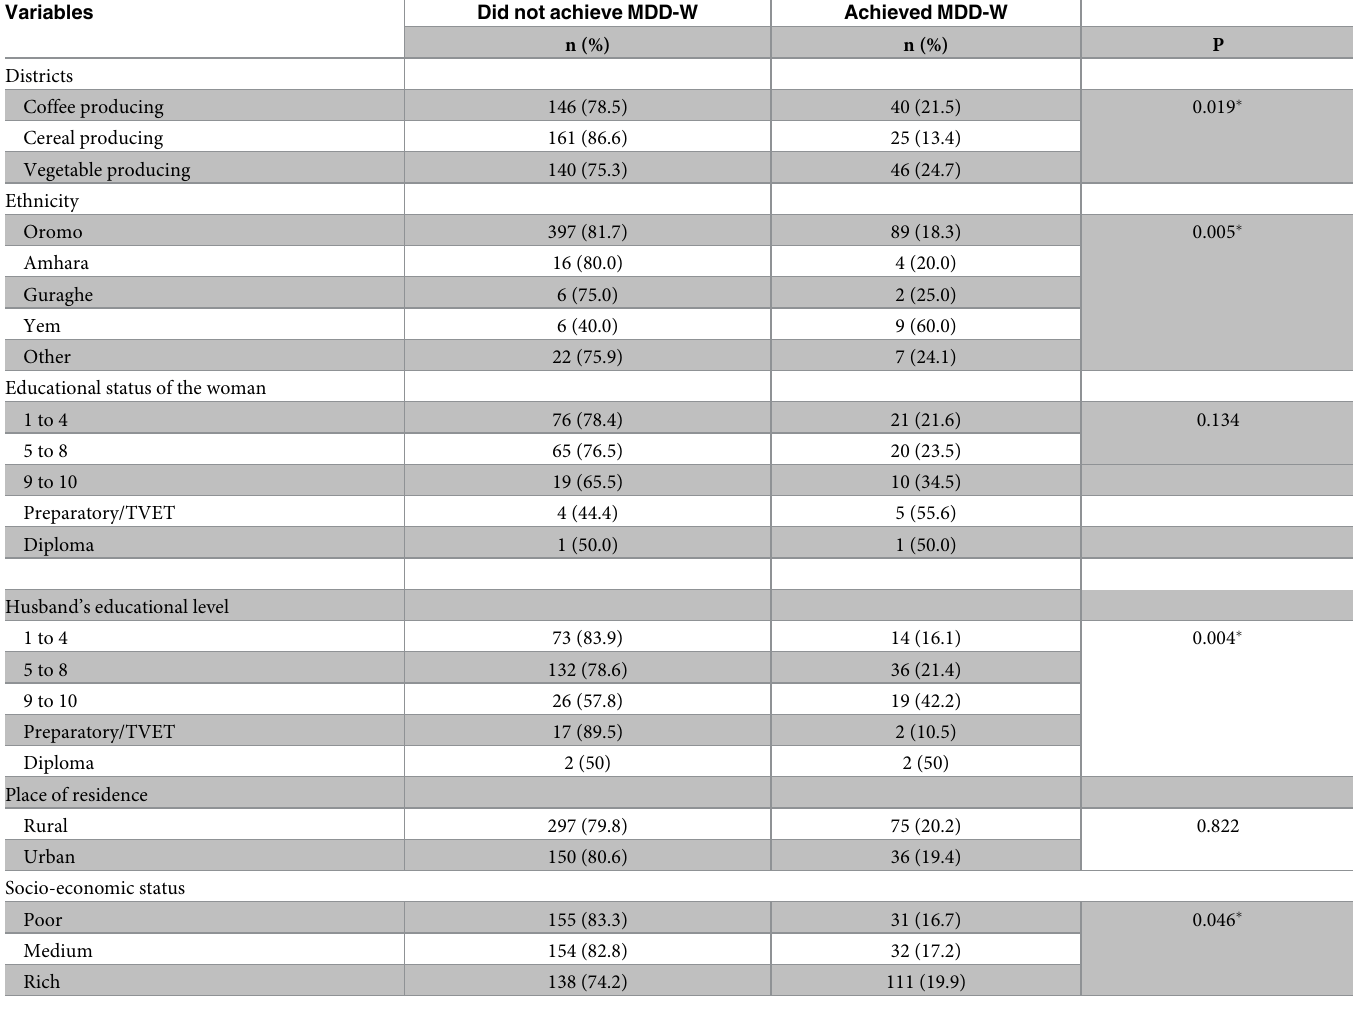
Table 4. Distribution of maternal dietary diversity by different variables in Jimma Zone, Southwest